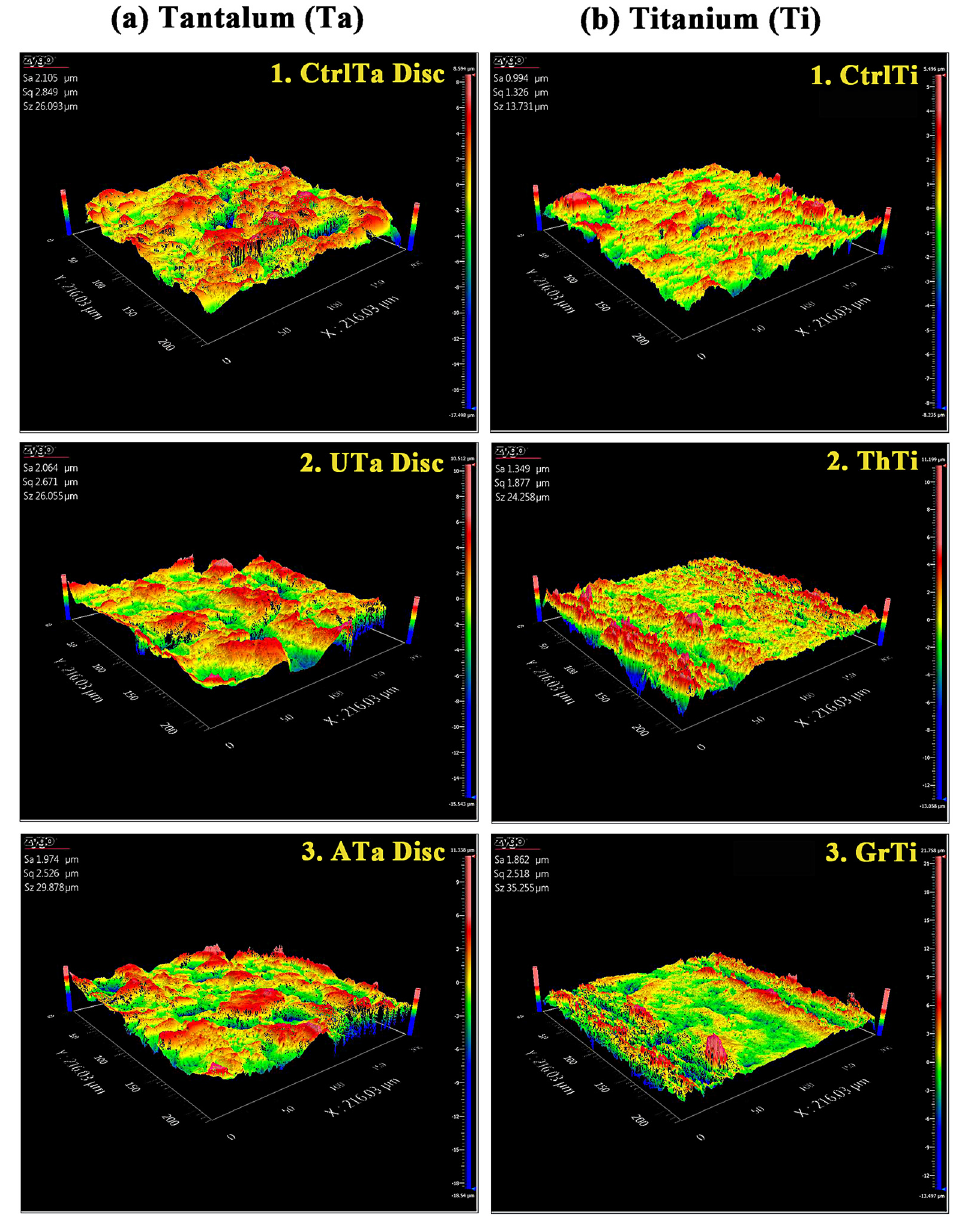
Figure 3. Quantitative analysis of surface roughness (Sa) by an optical interferometer. ( a ) Ta discs; 1. CtrlTa Disc, 2. UTa Disc, 3. ATa Disc; ( b ) Ti; 1. CtrlTi, 2. ThTi, 3. GrTi.